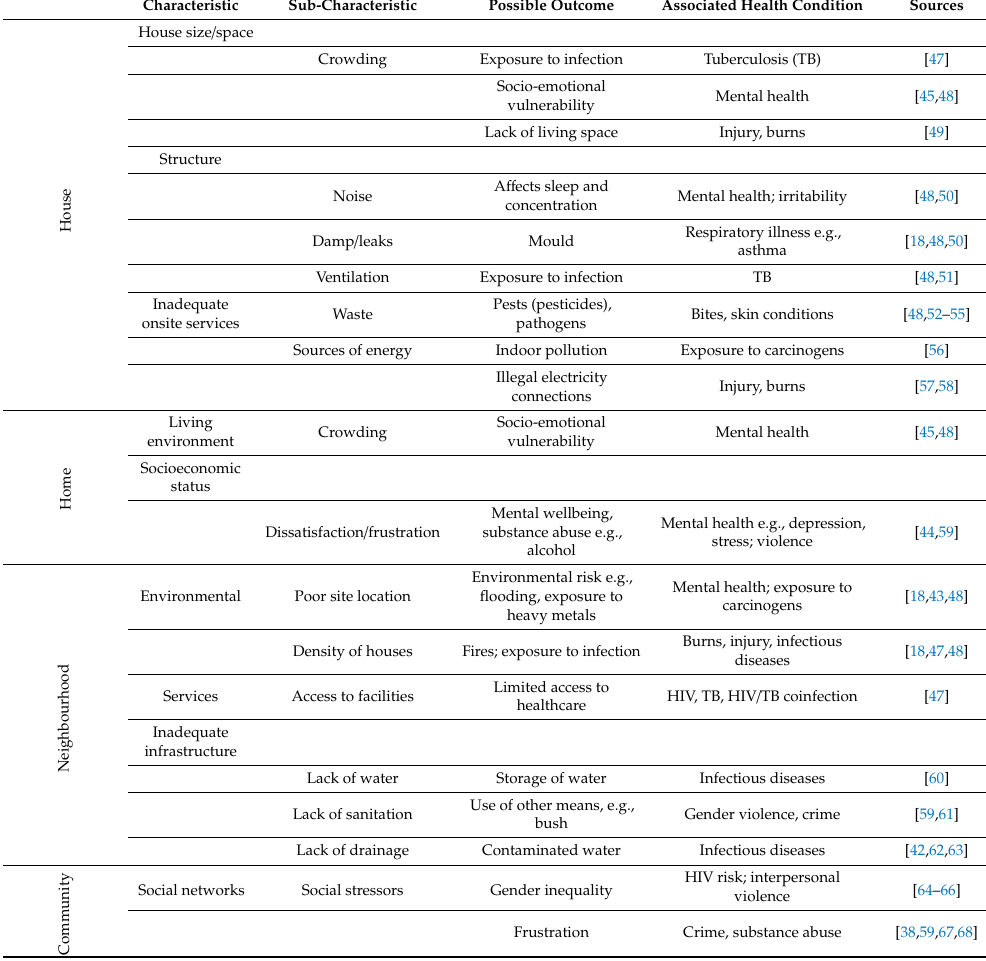
Table 1. Overview of informal settlement characteristics examples and the associated health conditions categorised by the four World Health Organization (WHO) dimensions of housing